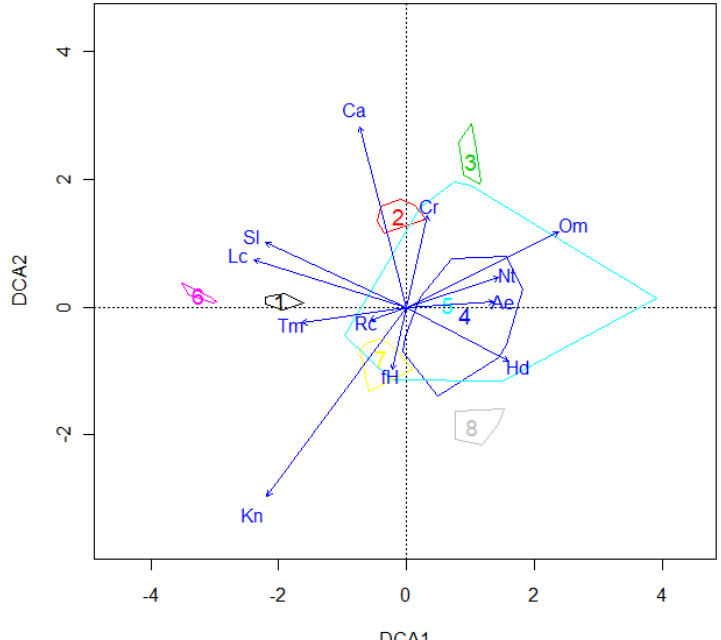
Fig. 7. Results of the ordination analysis of the syntaxa in the class